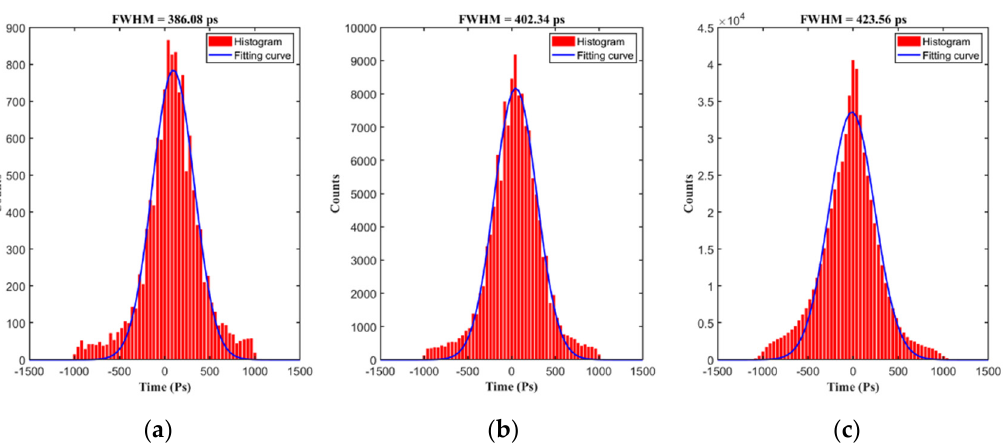
Figure 12. The coincident time resolutions of the crystal arrays with ( a ) BaSO 4 reflectors, ( b ) Toray film reflectors ( c ) ESR reflectors.